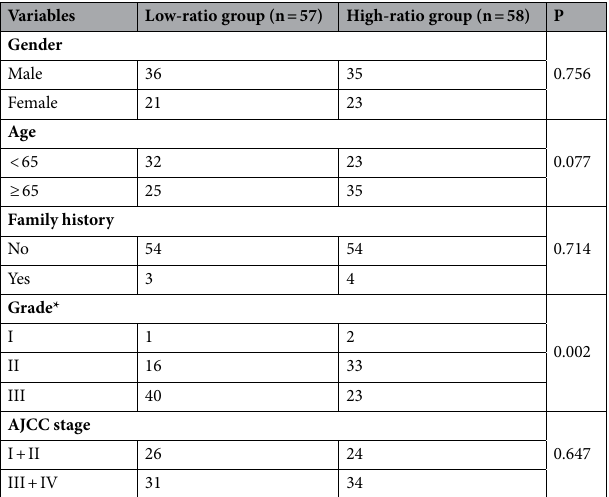
Figure 3. The optimal cutoff value of IL-6/IL-10 mRNA expression ratio determined by X-tile. ( A-B ) The greatest survival differences were obtained when the cutoff value of IL-6/IL-10 mRNA expression ratio was set at 1.3 and 5.5. ( C ) Kaplan–Meier overall survival curves for the low-, medium-, and high-ratio group. ( D ) Kaplan– Meier disease-specific survival curves for the low-, medium-, and high-ratio group. Variables Low-ratio group (n = 57) High-ratio group (n = 58)